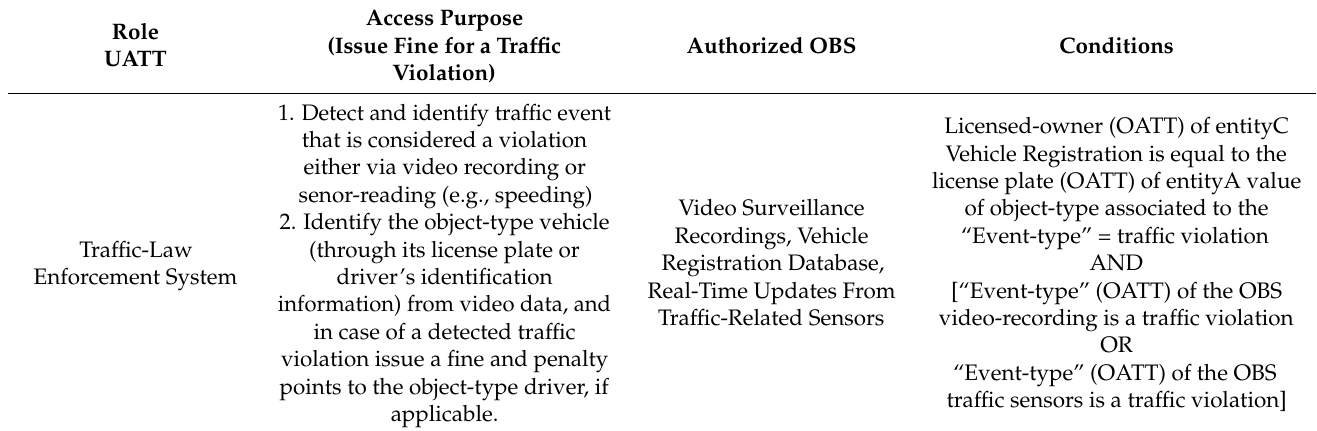
Table 5. Access purpose for DP/user (traffic law enforcement